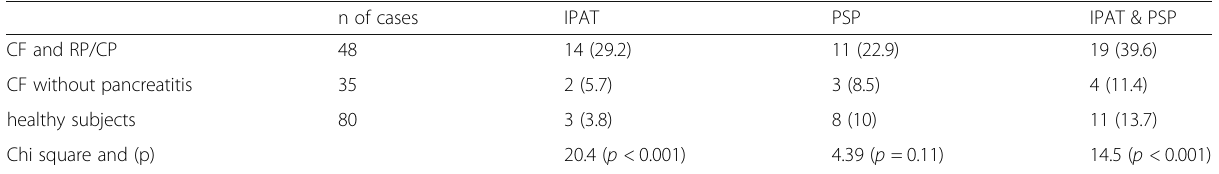
Table 1 Number and % of subjects with mutations in IPAT genes; PSP genes and at least one gene (IPAT & PSP) in: patients with CF and recurrent/chronic pancreatitis (RP/CP); patients with CF without pancreatitis and healthy